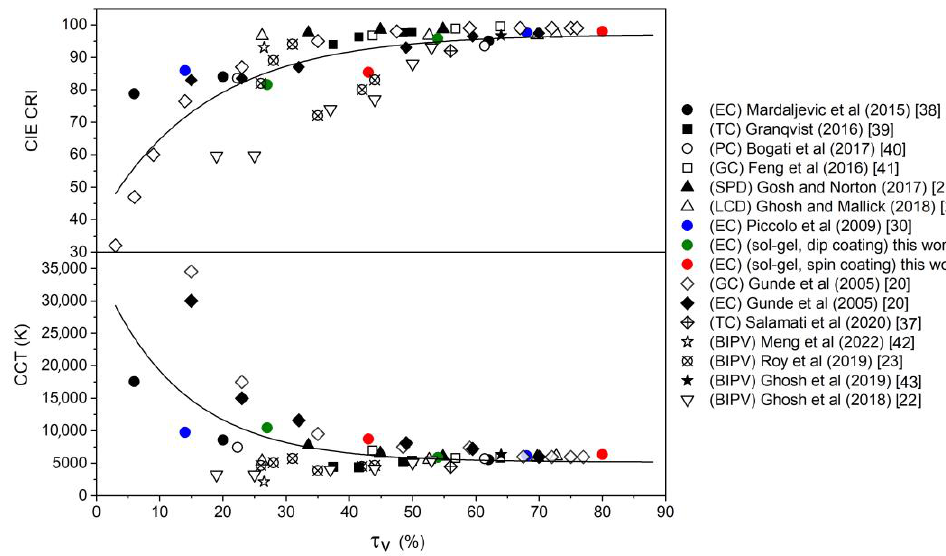
Figure 5. The CIE CRI and CCT indexes as a function of the visible transmittance of selected advanced glazing. Continuous lines are least-squares fits of the experimental points by an exponential growth (upper half diagram) and exponential decay (lower half diagram) function.